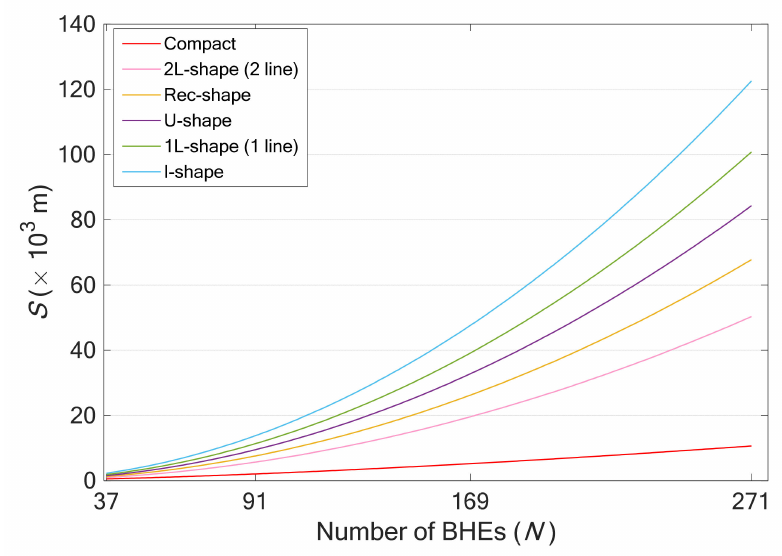
Figure 10. Different S values according to increase in N for test bore field